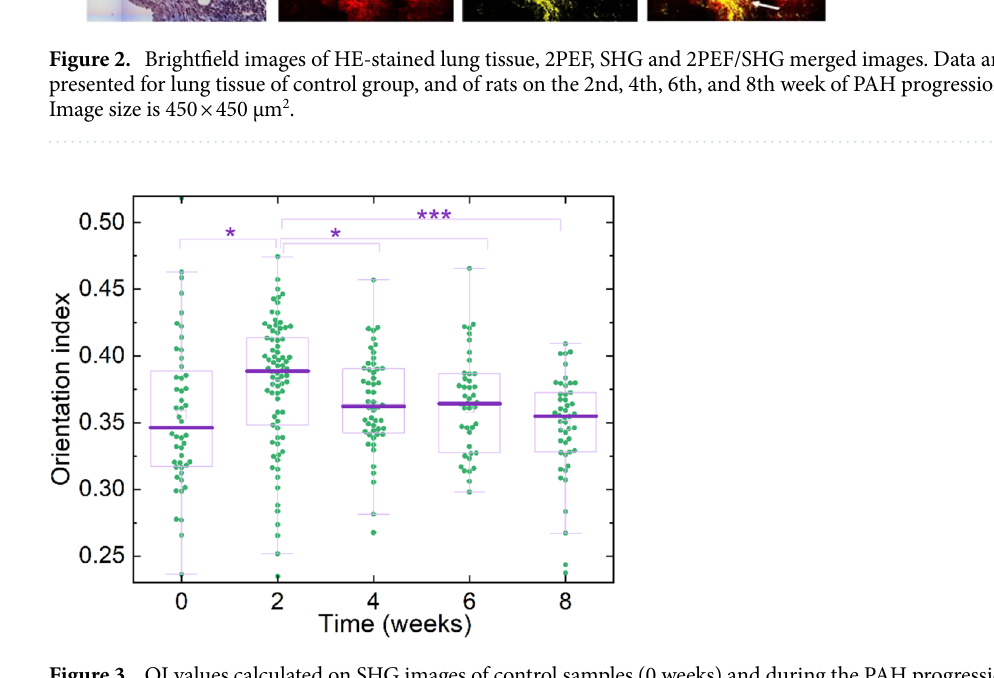
Figure 3. OI values calculated on SHG images of control samples (0 weeks) and during the PAH progression. The statistical significance of the difference of different distributions is p < 0.1*, and p <